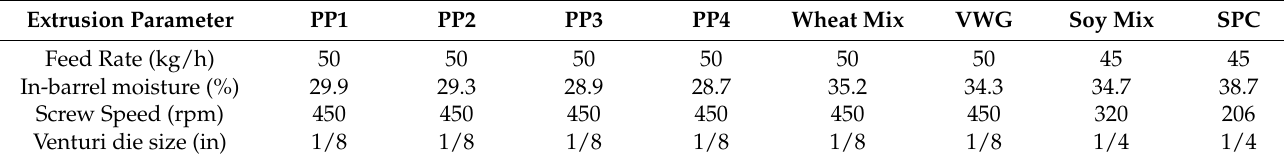
Table 3. Extrusion parameters for each treatment. All parameters remained consistent for pea protein (PP) treatments, while optimization was required for Wheat Mix, vital wheat gluten (VWG), Soy Mix, and soy protein concentrate (SPC). The remaining variables were kept constant.